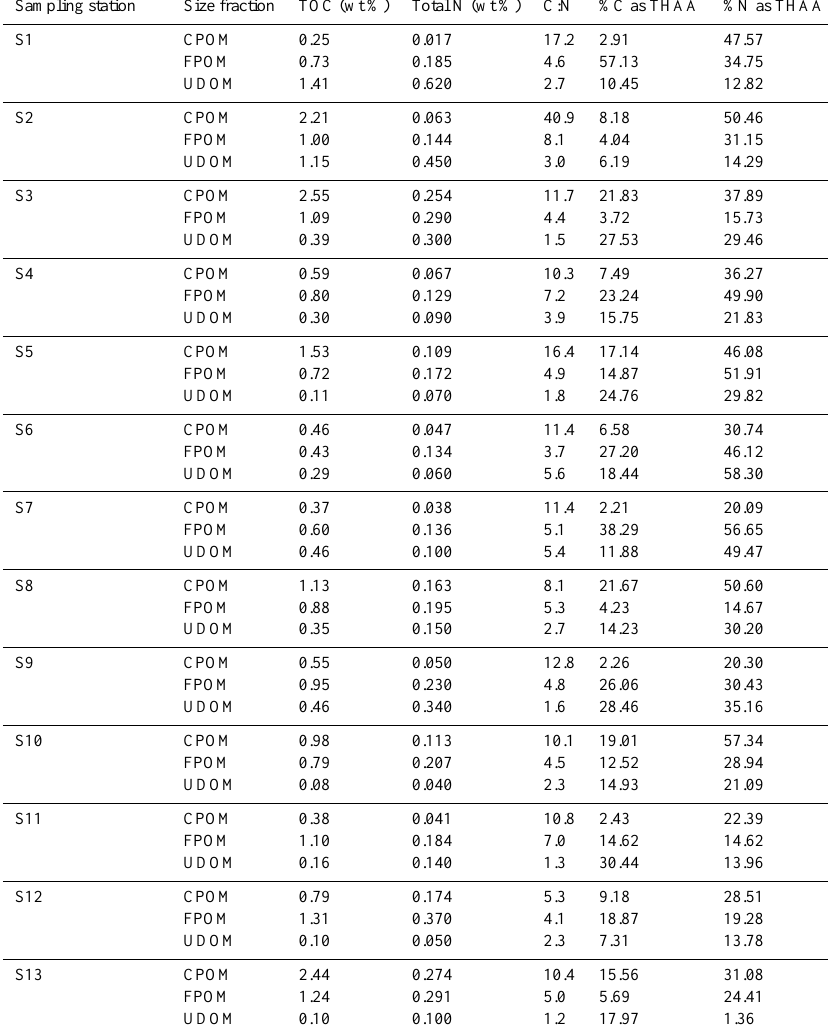
Table 3. Total organic carbon (TOC) and total nitrogen (Total N) contents, C:N ratios (mole TOC:Total N), percentages of TOC and total N as total hydrolysable amino acids (THAA) in sediment samples of different size